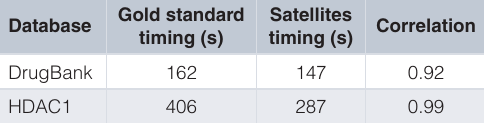
Table 2. Benchmark with larger